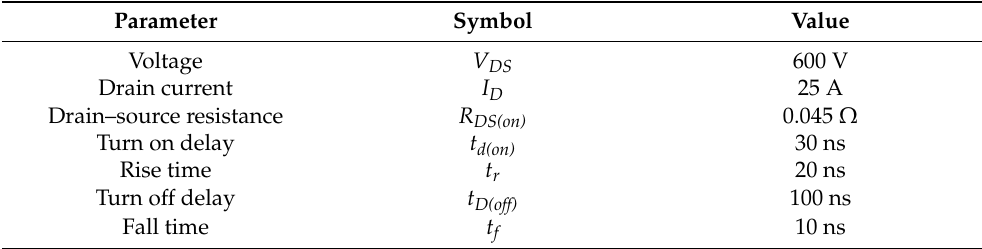
Table 1. IPW65C7045